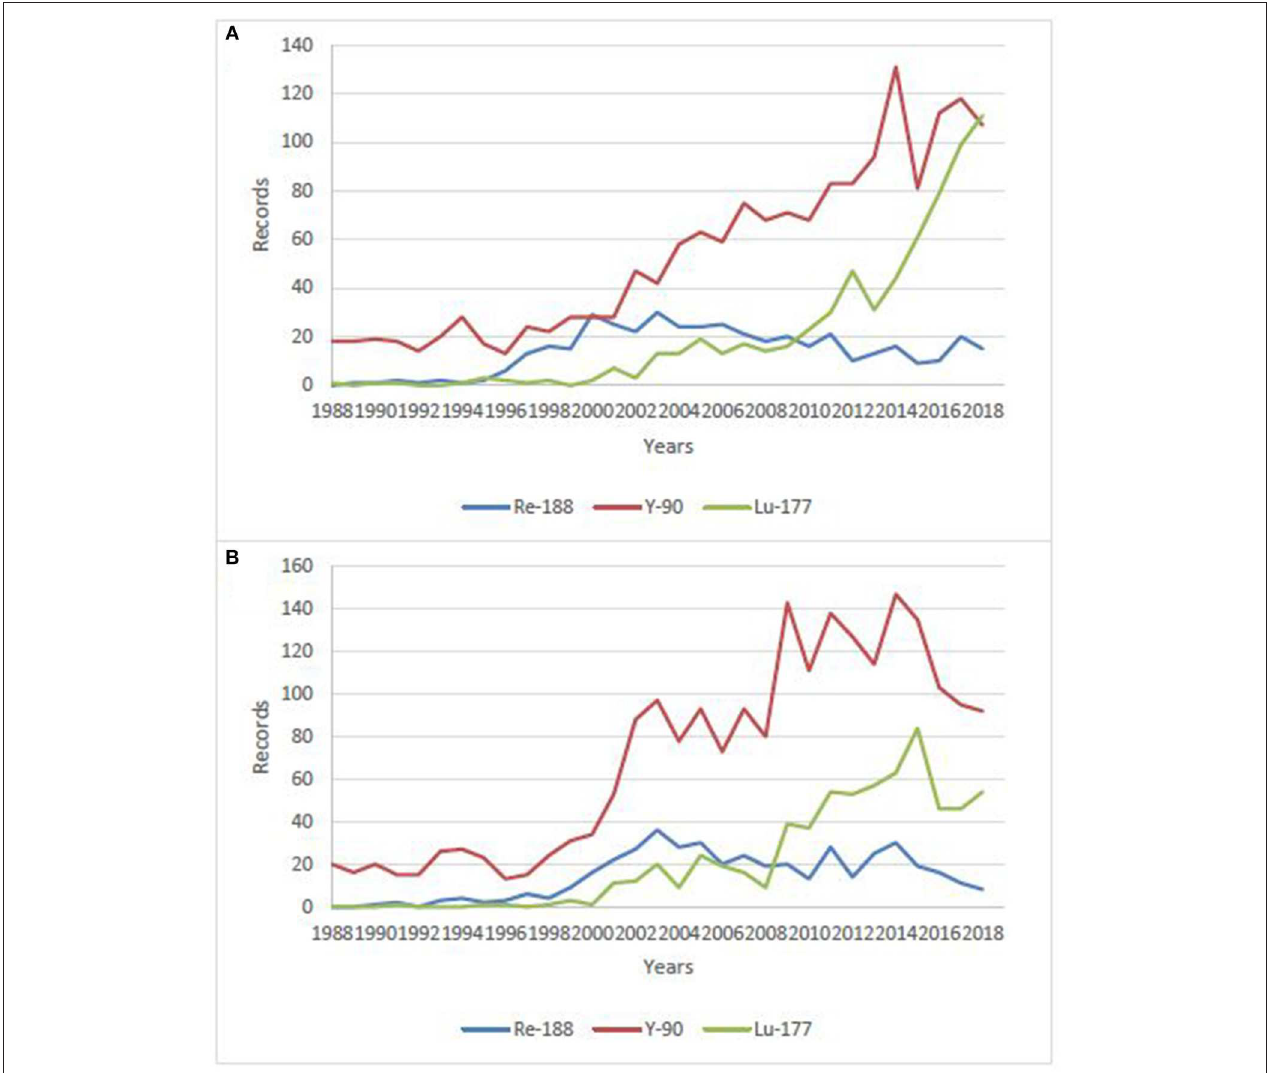
FIGURE 1 | Number of publications/year on clinical use of 188 Re, 177 Lu and, 90 Y over the last 30 years. (A) data from Sci-Finder, © 2019 American Chemical Society, (B) data from Web of Science, © 2019 Clarivate